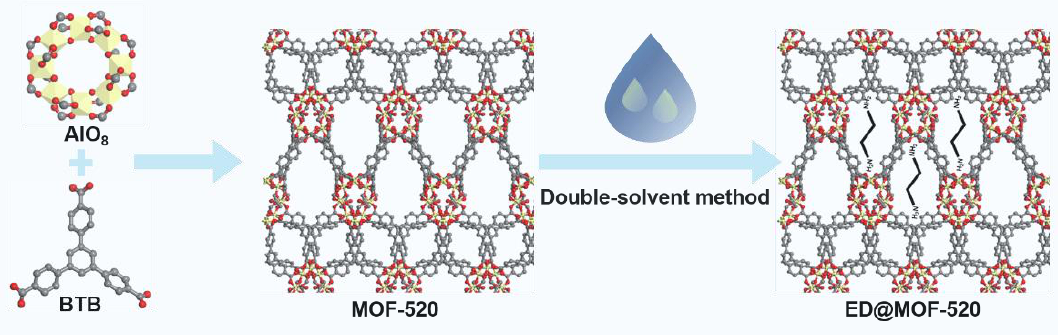
Figure 1. Synthesis schematic diagram of MOF-520 and ED@ MOF-520, where the yellow, red, and gray color represents Al, O, and C atom, respectively.